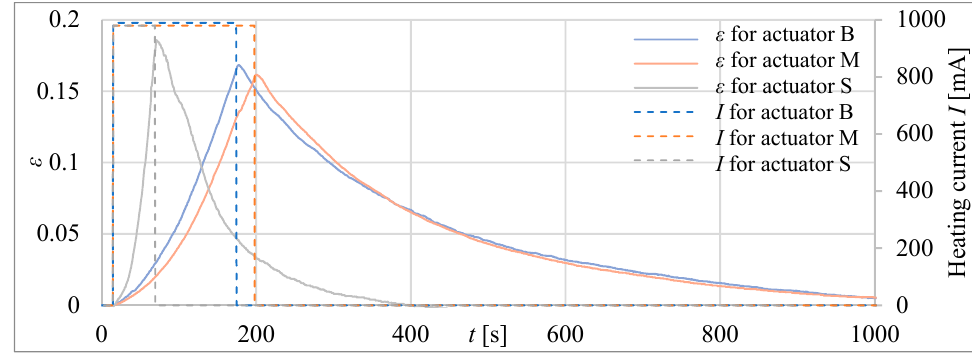
Figure 18. Relative elongation for bellow actuators.